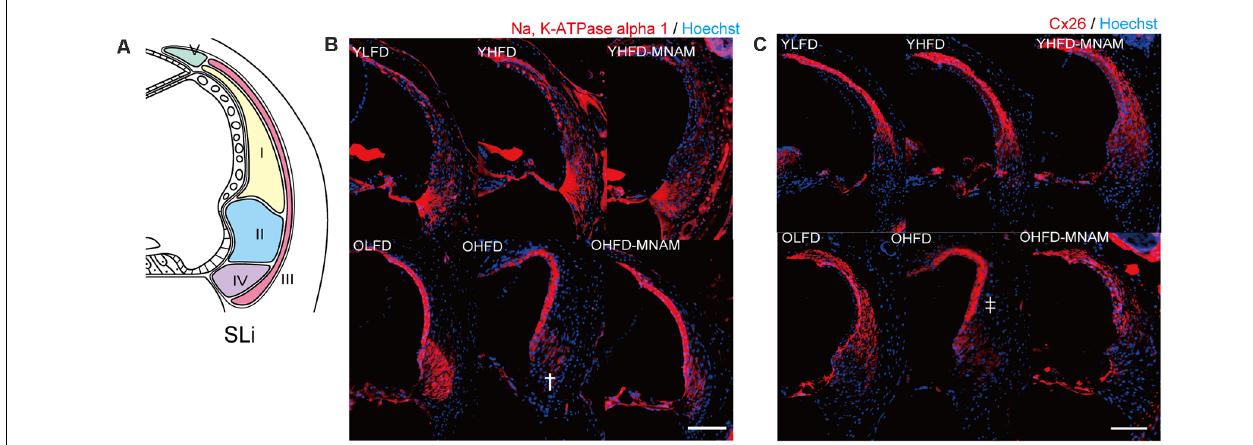
FIGURE 4 | Morphological analysis of the spiral ligament (SLi): age-related SLi alterations are observed in OHFD mice. (A) The schema of the SLi. The fibrocytes of SLi are divided into five types. (B) The immunostaining of types II and IV in the SLi using an anti-Na, K-ATPase alpha 1 antibody at 6 months after experiment initiation. The dagger symbol indicates a decrease in Na, K-ATPase alpha 1 expression in the cochlea of OHFD mice after the commencement of the experiment. (C) The immunostaining of type I and V cells in the SLi using the anti-Cx26 antibody at 3 and 6 months after experiment initiation. The double dagger symbol indicates a decrease in Cx26 expression in the cochlea of the OHFD mice after the commencement of the experiment (Bars: 100 µ m; YLFD, low-fat diet-fed 3-month-old mice; OLFD, low-fat diet-fed 6-month-old mice; YHFD, high-fat diet-fed 3-month-old mice; OHFD, high-fat diet-fed 6-month-old mice; YHFD-MNAM, high-fat diet plus 1% N 1 -methylnicotinamide-fed 3-month-old mice; OHFD-MNAM, high-fat diet plus 1% N 1 -methylnicotinamide-fed 6-month-old mice; OCs, the organ of Corti; SGC, spiral ganglion cells; SLi, spiral ligament; SV, stria